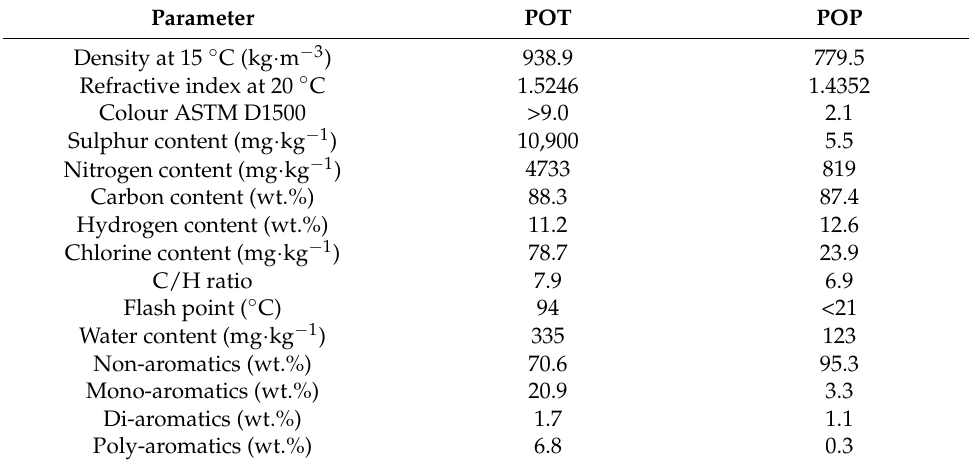
Table 1. Analytical characterisation of the used pyrolysis oils.